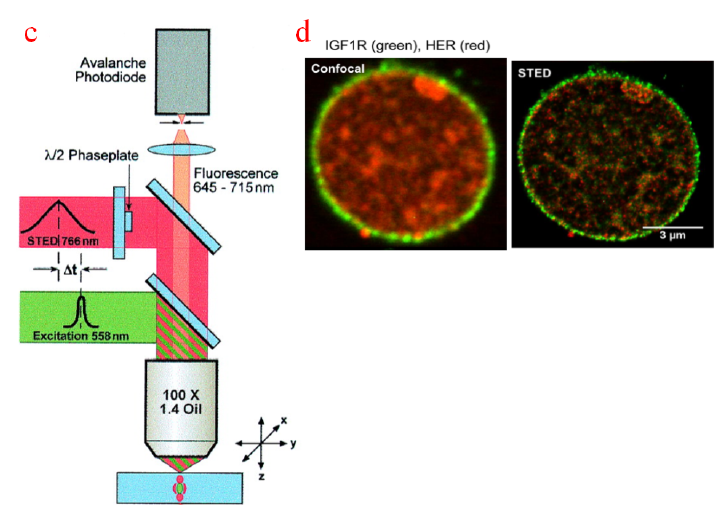
Figure 4. Super-resolution microscopy. ( a ) Configuration of a typical structured illumination microscope (SIM). Adapted with permission from Reference [110]; ( b ) Imaging comparison of cytoskeletal and nuclear components between SIM and WFFM. Adapted with permission from Reference [109] © The Optical Society; ( c ) Schematic of a stimulated emission depletion microscope (STEDM). Adapted with permission from Reference [113]. Copyright (2000) National Academy of Sciences, U.S.A.; ( d ) Imaging comparison of living hippocampal primary neurons between STEDM and CFM. Adapted with permission from Reference [115]. Table 1. Comparison of image sampling methods based on different principles.